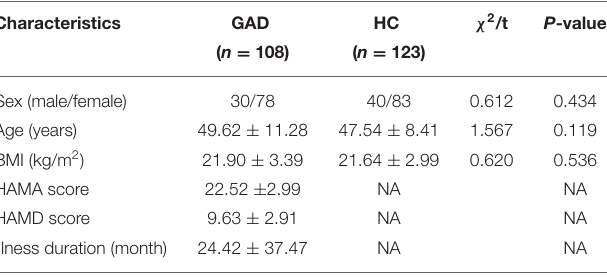
TABLE 1 | Demographic information of GAD and HC. Characteristics